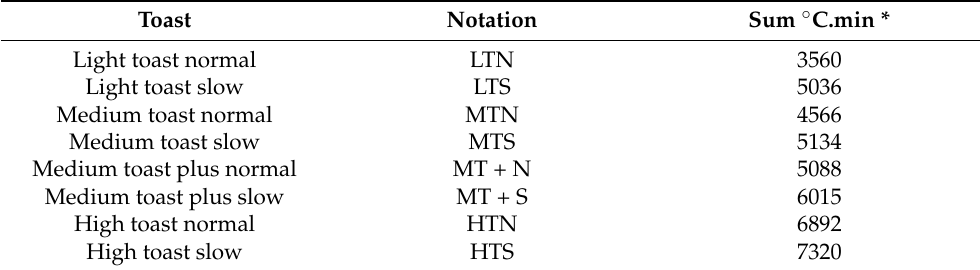
Table 1. Description of te types of barrel toasting